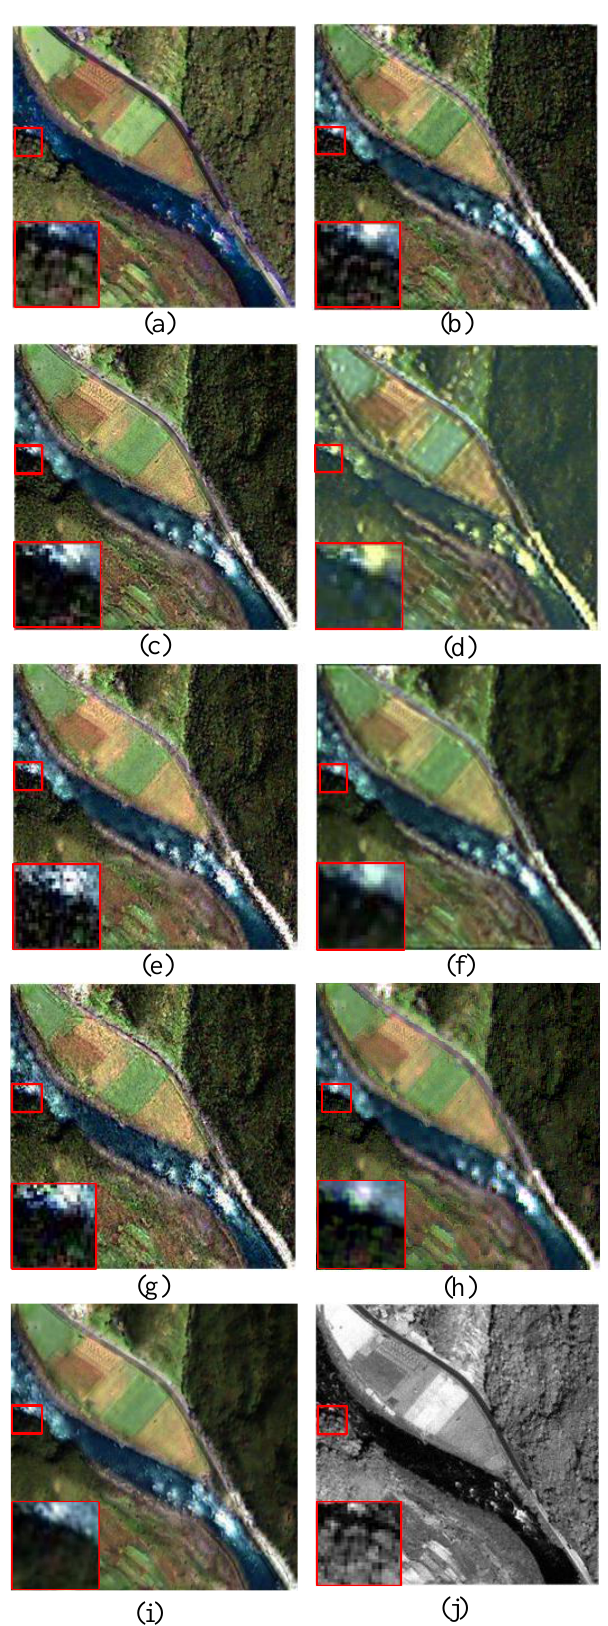
Figure 11. The real results on the IKONOS dataset. ( a ) GS. ( b ) Indusion. ( c ) SR. ( d ) PNN. ( e )